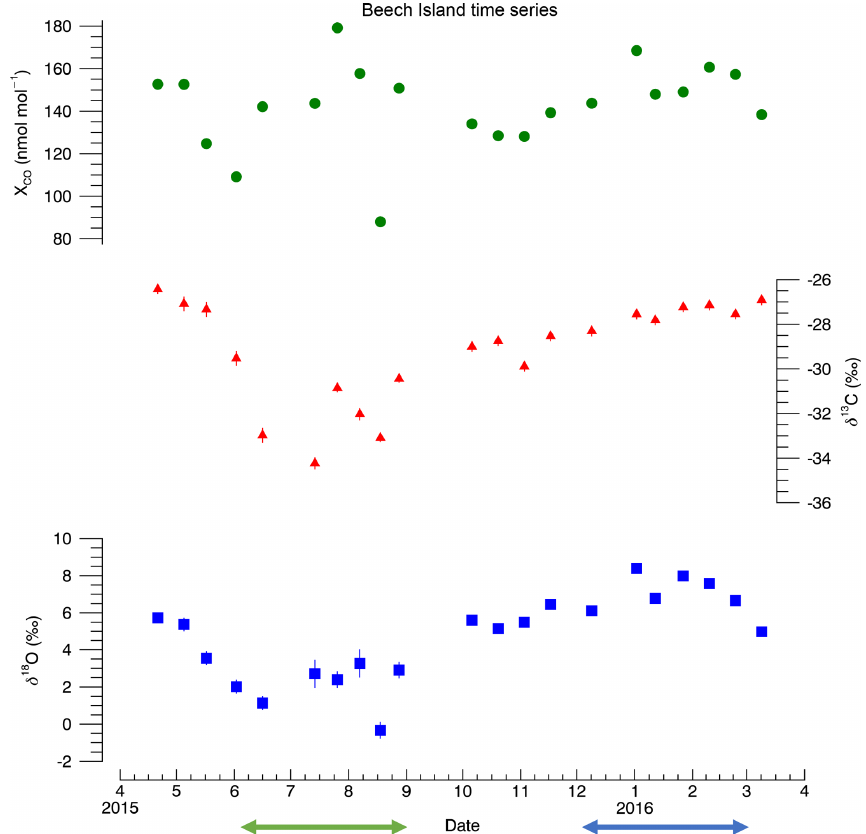
Figure 4. Time series for Beech Island, South Carolina. No curves were fit to the data due to the short time frame for the measurements. The error bars represent 1 σ analytical uncertainty. CO mole fraction 1 σ uncertainty is ± 0.5 nmol:mol. Uncertainty for δ 13 C and δ 18 O is listed in the Supplement (Table S3). The CO mole fraction data are taken from the NOAA GGGRN data set (Andrews et al., 2009). The green and blue arrows indicate the summer and winter periods used in this study,